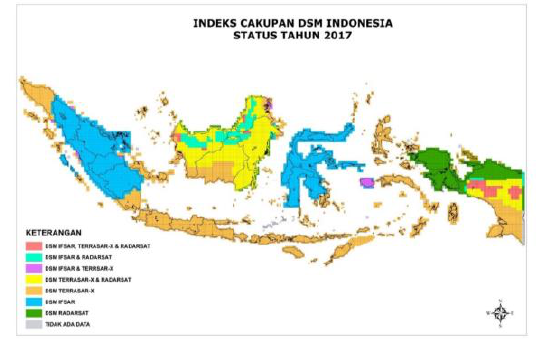
Figure 1. DSM coverage in